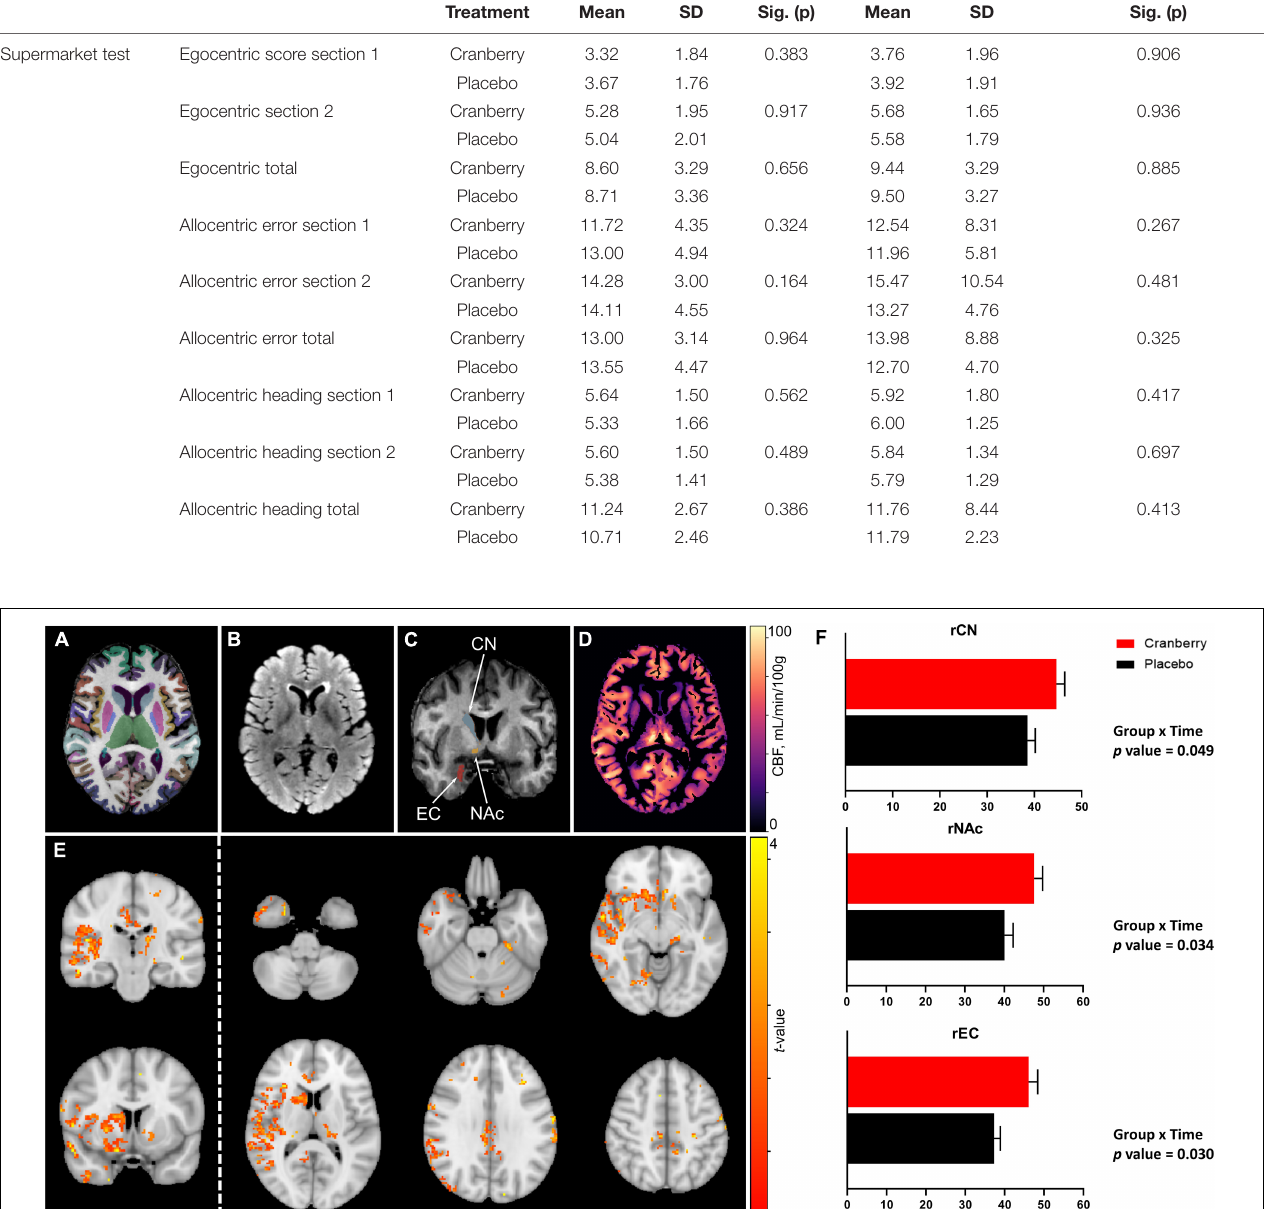
Frontiers in Nutrition |